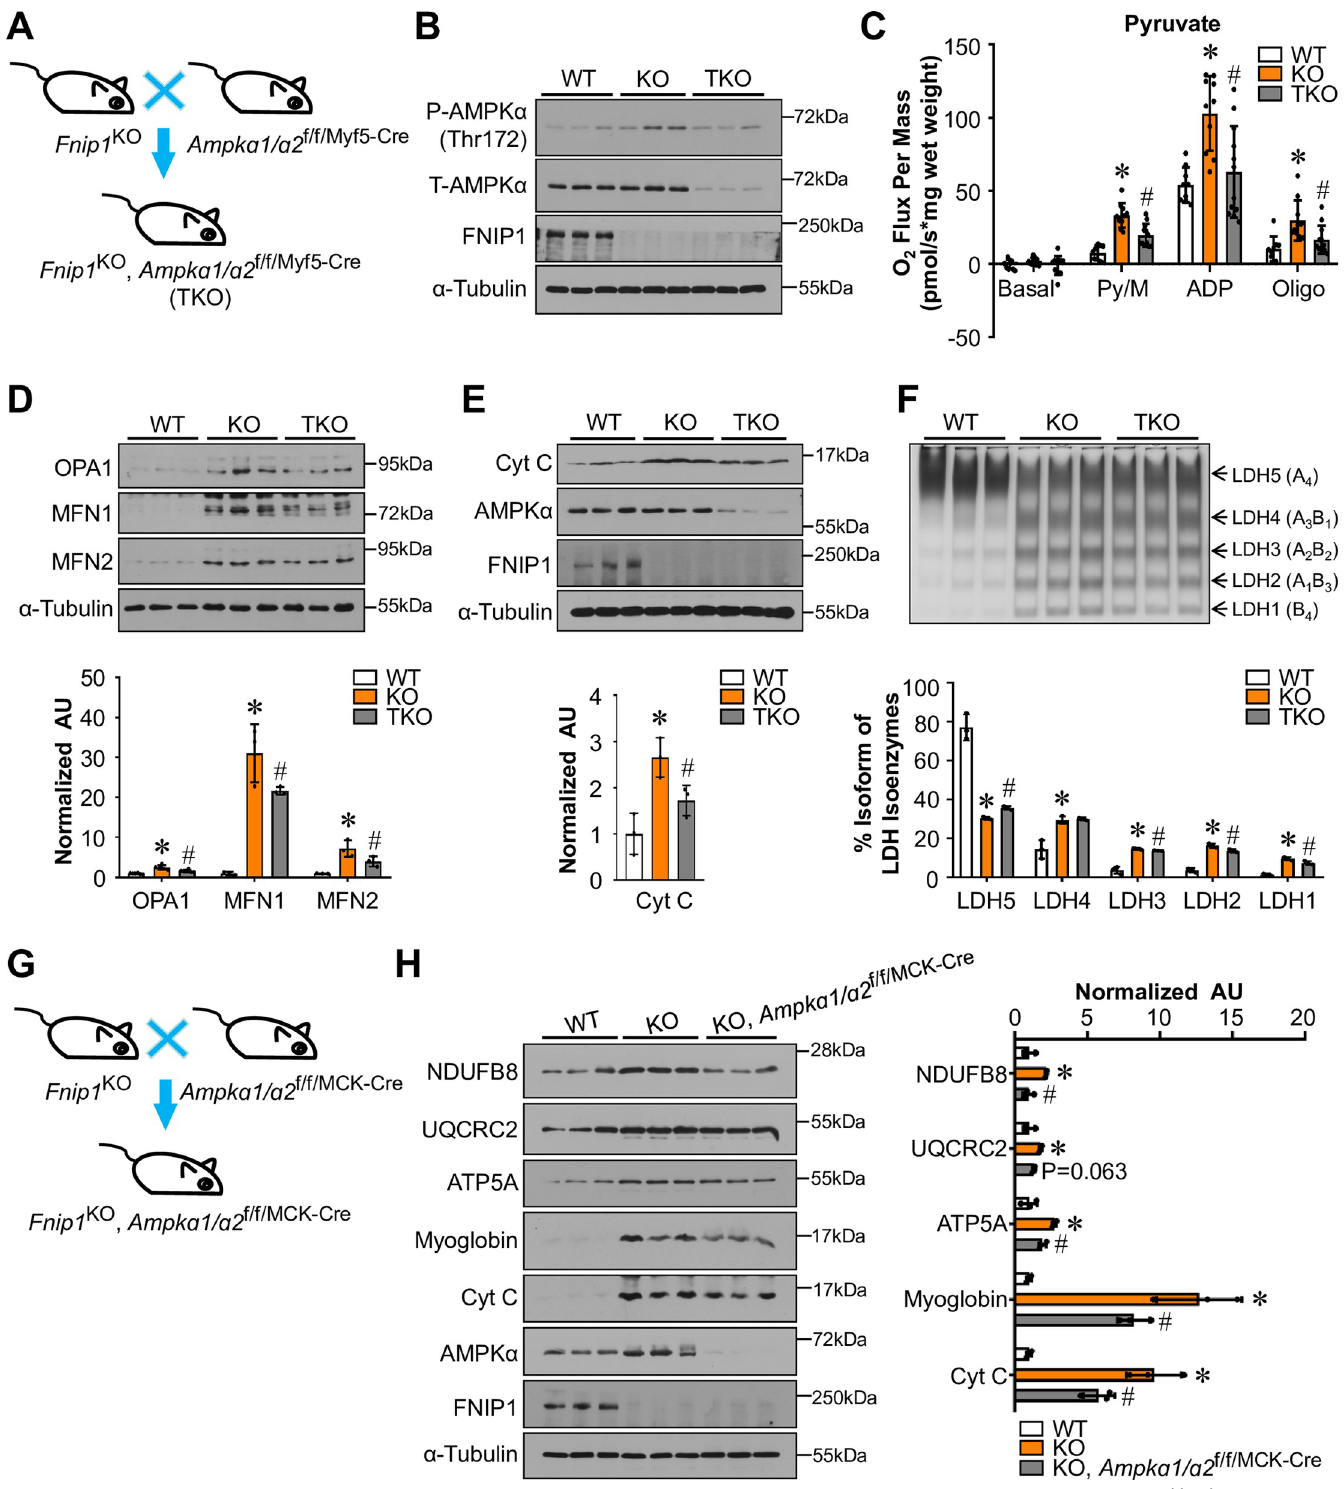
Fig 4. FNIP1 regulates muscle mitochondrial oxidative programs through AMPK. ( A ) Schematic showing the creation of Fnip1 KO , AMPKa1/a2 f/f/Myf5-Cre (TKO) mice. ( B ) Representative immunoblot analysis performed with EDL muscle total protein extracts prepared from the indicated mice using p-AMPK α (Thr172), AMPK α , FNIP1 and α -Tubulin (control) antibodies. n = 6 mice per group. ( C ) Mitochondrial respiration rates were determined from EDL muscle of the indicated genotypes using pyruvate as a substrate. Pyruvate/malate (Py/M)-stimulated, ADP-dependent respiration and oligomycin-induced (Oligo) are shown. n = 9–12 mice per group.